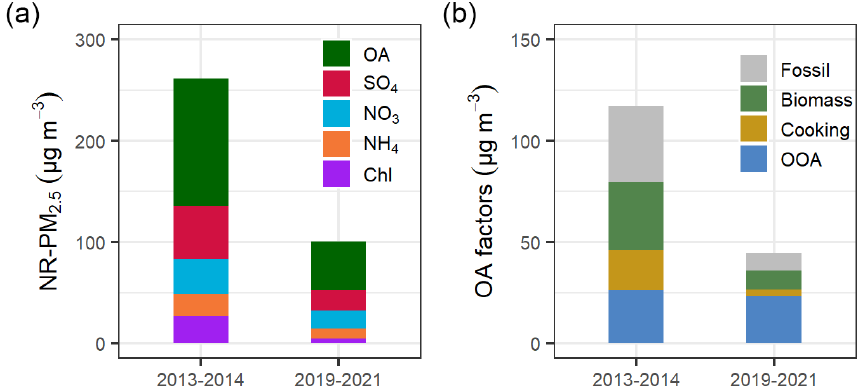
Figure 4. (a) Mean chemical composition of non-refractory particulate matter (NR-PM 2 . 5 ) and the OA factor for winter in 2012–2014 and